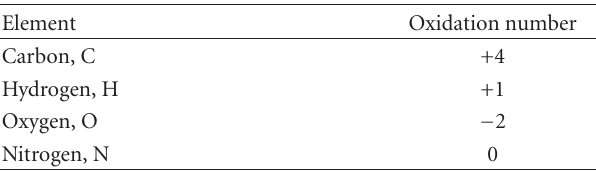
Table 5: Oxidation numbers of elements of interest in the saturated stoichiometric products